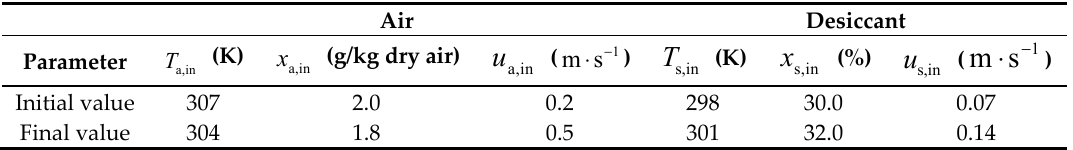
Table 1. Summary of calculating